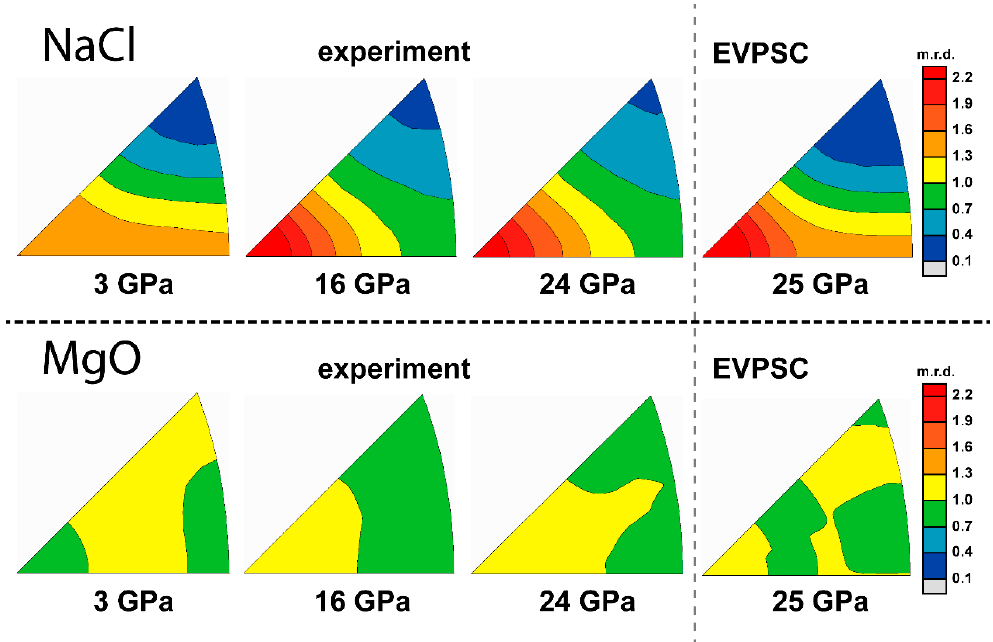
Figure 7. IPFs of experimental and modeled textures of 20% MgO + 80% NaCl. Scale bar is given in multiples of random distribution (m.r.d.)